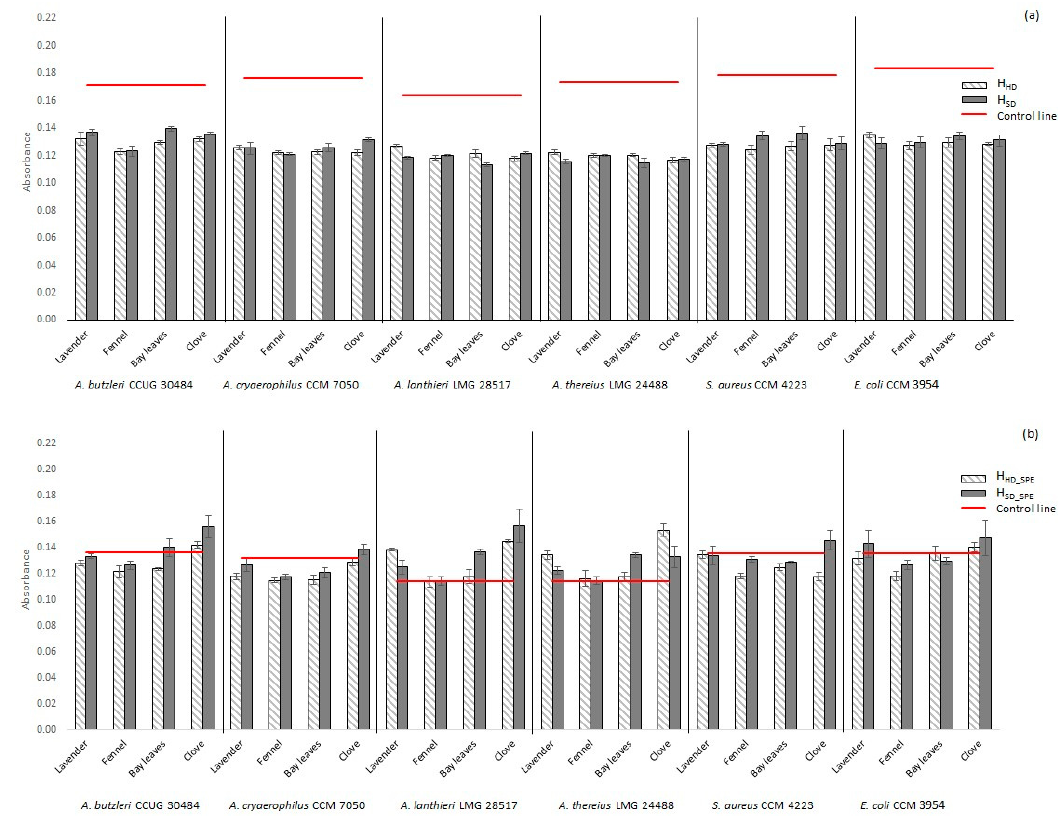
Figure 1. Biofilm formation in the presence of non-concentrated hydrolates ( a ) and concentrated hydrolates ( b ). Bars represent standard deviation, n = 3. H HD —hydrolate obtained by hydrodistillation; H SD —hydrolate obtained by steam distillation; H HD_SPE —hydrolate obtained by hydrodistillation and 50 × concentrated using solid phase extraction (SPE); H SD_SPE —hydrolate obtained by steam distillation and 50 × concentrated using SPE. Red lines—biofilm formation of strains in water ( a ), biofilm formation of strains in extraction solvent ( b ); values above / below the red lines—increased / reduced biofilm formation due to hydrolate presence.